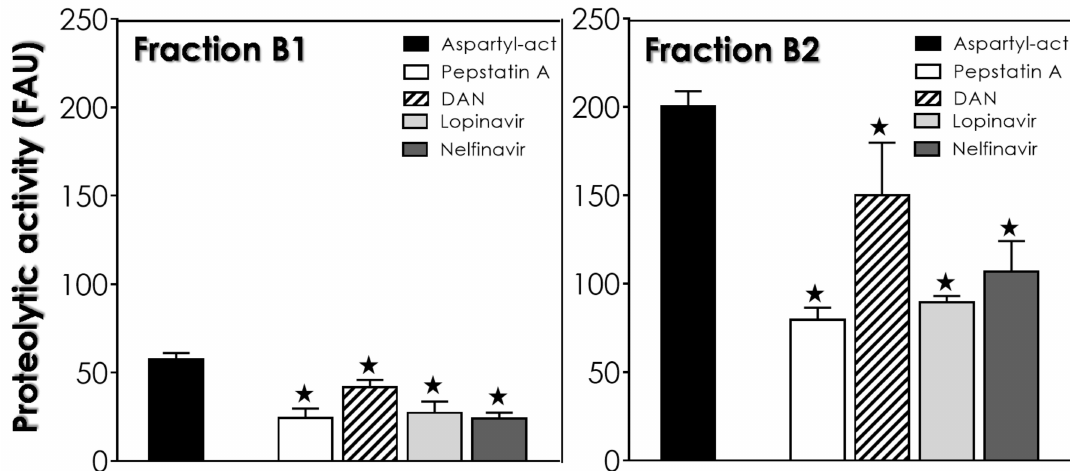
Figure 3. Effects of lopinavir and nelfinavir on the aspartyl-type activity of Fractions B1 and B2 of the reservosomes. The aspartyl-type peptidase activity (act) was quantified fluorometrically over cathepsin D substrate in the absence ( control: black bars ) or in the presence of lopinavir and nelfinavir at 10 µ M. The classical aspartyl peptidase inhibitors pepstatin A and DAN at 10 µ M were also included in the assays. The results are expressed as fluorescence arbitrary units (FAUs), which represent the fluorescence liberated by the fluorophore in 60 min of reaction. Values represent the mean ± standard deviation of three independent experiments. The black stars represent significant statistical differences in systems with pepstatin A compared to the respective controls ( p <